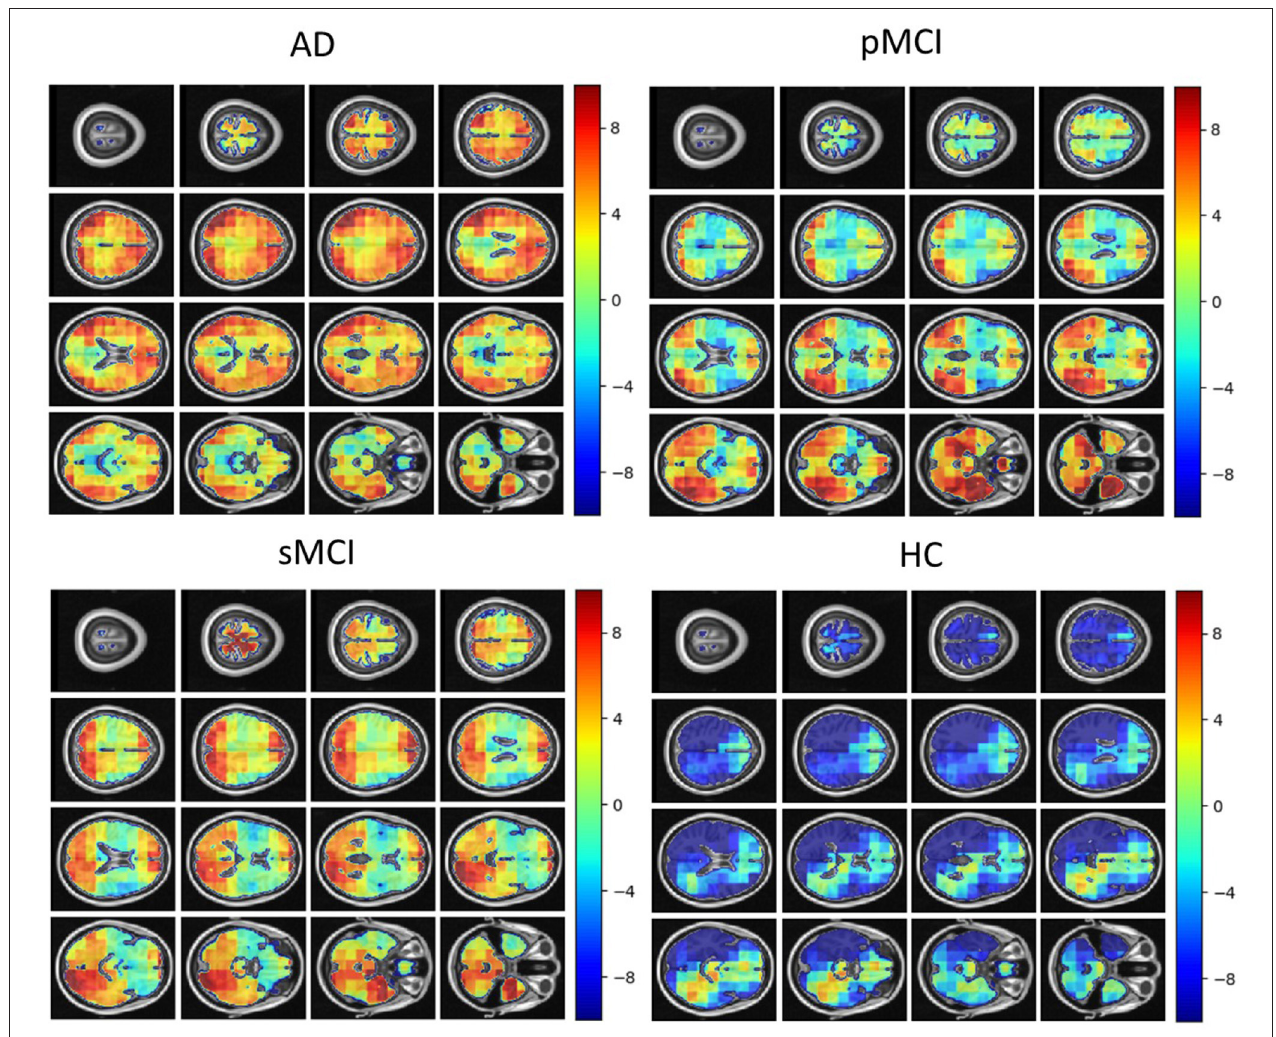
FIGURE 8 | Local brain-PAD maps for randomly sampled participants from clinical groups in cross-sectional OASIS3 dataset. Positive values indicate an increased pattern of local volume differences compared to healthy ageing patterns at the respective age. HC, Healthy Controls; pMCI, progressive MCI; sMCI, stable MCI; AD, Alzheimer’s